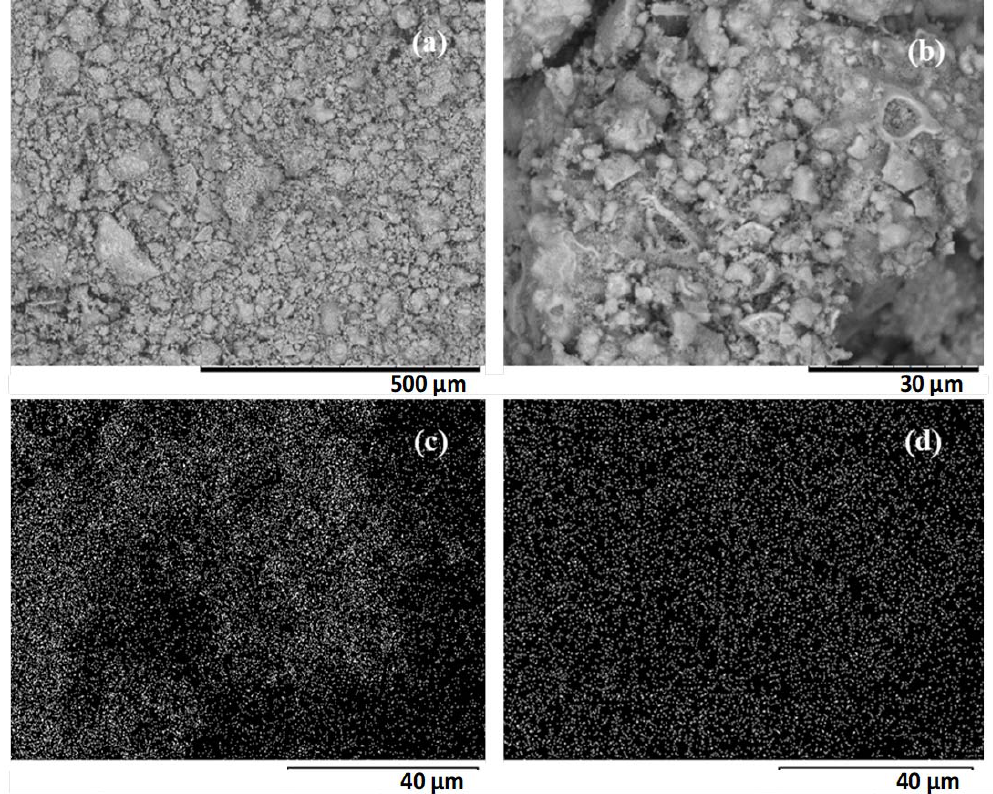
Figure 4. Scanning electron micrographs of HPW/Nb 2 O 5 ‐ 300 °C catalyst at ( a ) 200× magnification (scale bar: 500 μ m), ( b ) 2000× magnification (scale bar: 30 μ m), and X ‐ ray emission mapping of niobium ( c ) and tungsten ( d ) obtained at 2000× magnification (scale bar: 40 μ m).